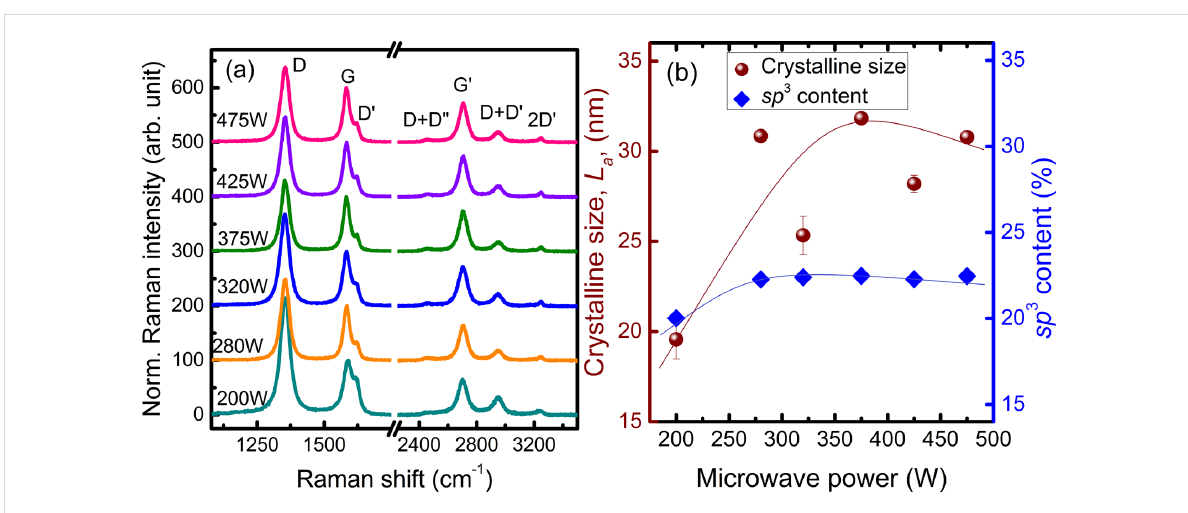
Figure 8: (a) Raman spectra of VGNs grown at a microwave power of 200 W, 250 W, 320 W, 375 W, 425 W and 475 W; (b) variation of crystallite size and sp 3 content as a function of the microwave power. Solid lines are to guide the eye.